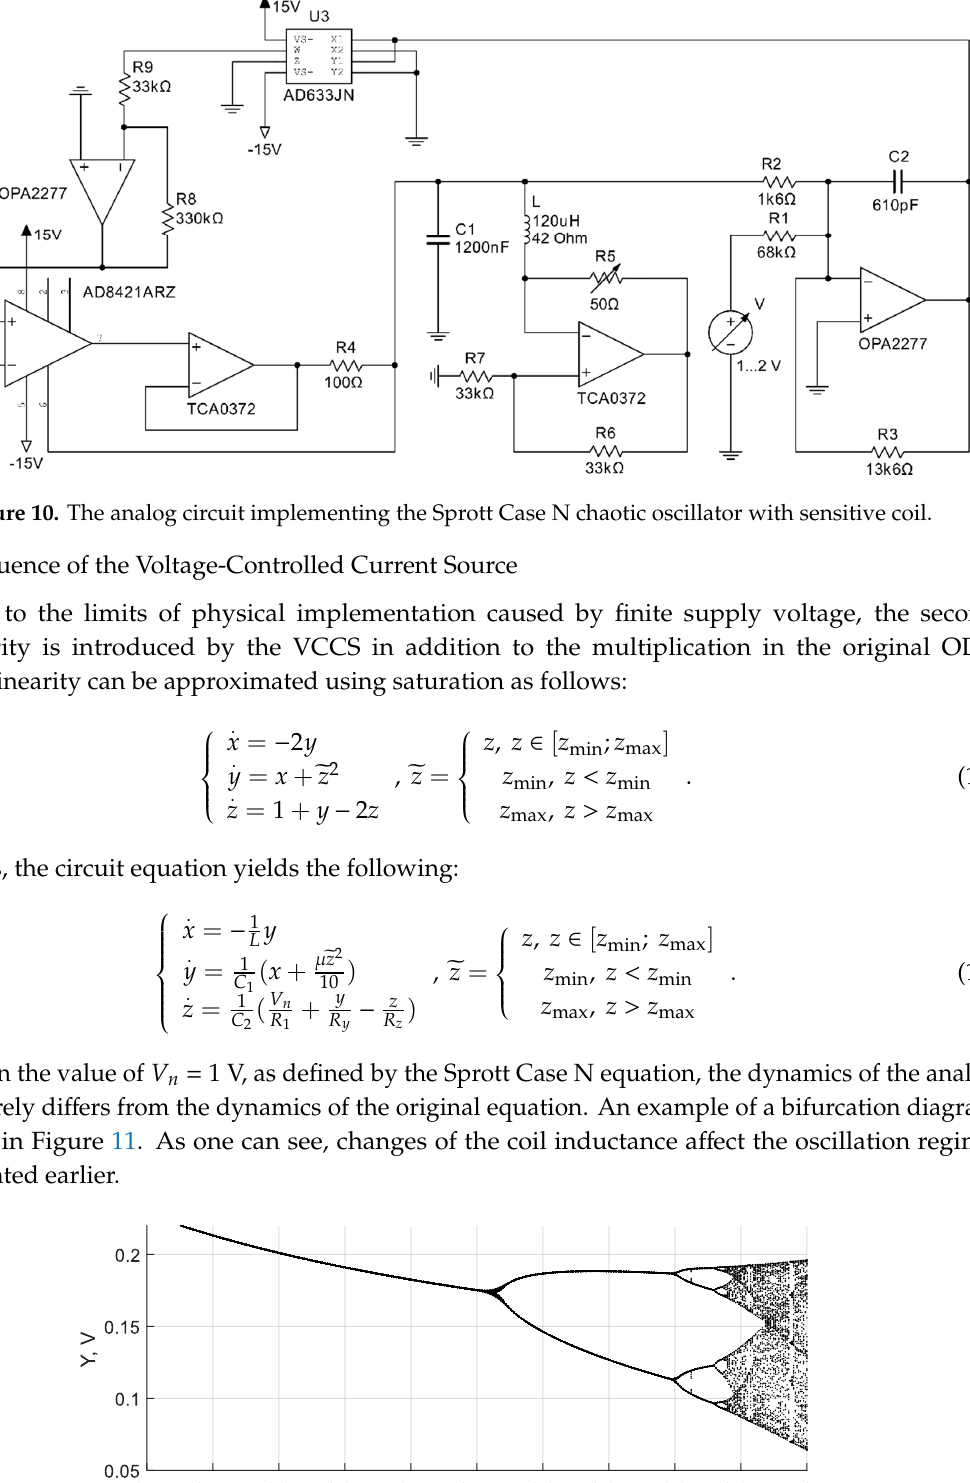
Figure 12. Attractor of the designed circuit in the chaotic mode of oscillations. Figure 13. Attractor of the designed circuit in the periodic mode of oscillations. Switching between chaotic and periodic mode may occur rapidly, as can be seen in the bifurcation diagram. A comparison of the bifurcation diagrams of the original Sprott Case N Equation (5) and the circuit simulation is presented in Figure 14. Value V5,1  n V was used in this numerical experiment.